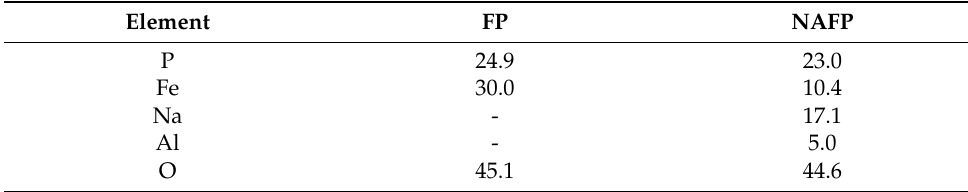
Table 1. Estimated elemental composition of FP and NAFP glass samples, wt%. Element